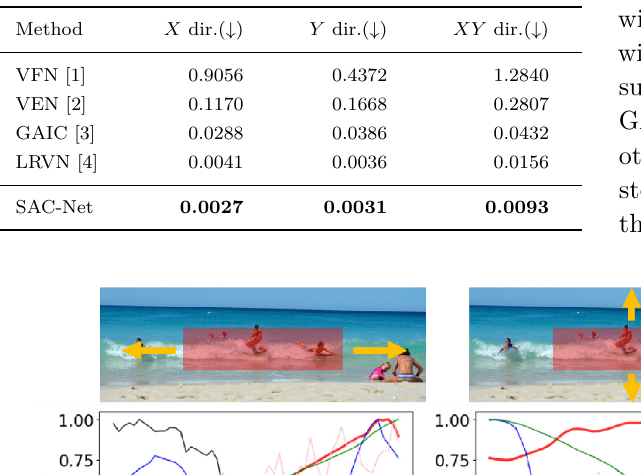
Table 3 Mean discrete curvature of plots in Fig. 7